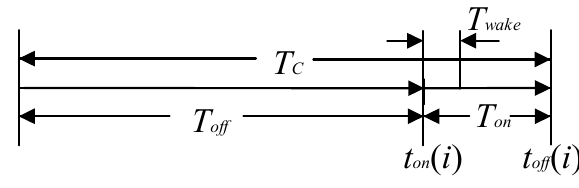
Figure 17. The opening and closing cycles of the sensing system.